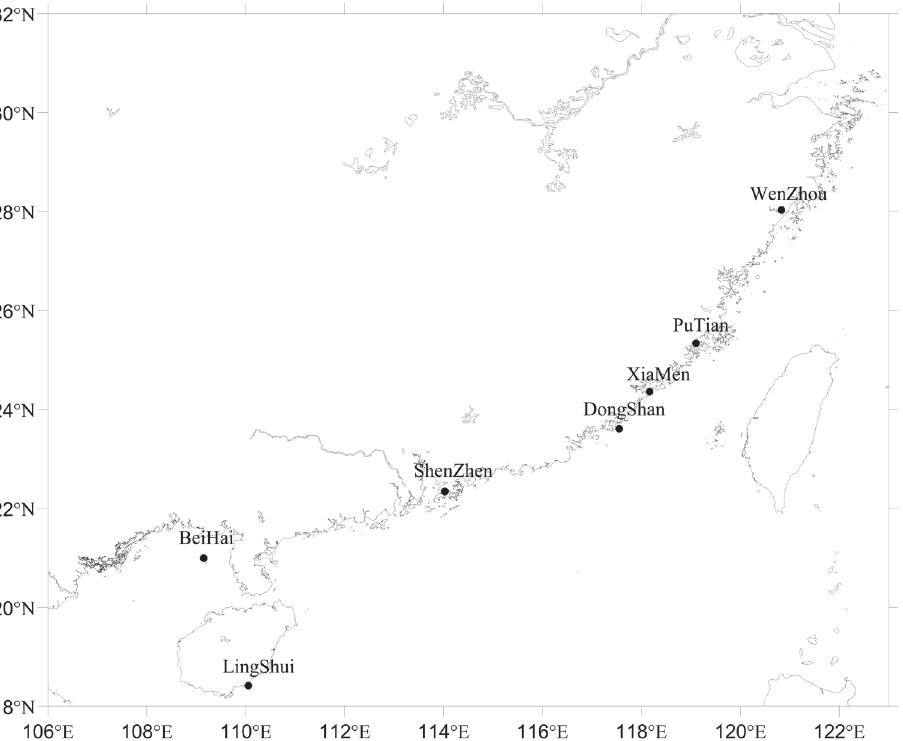
Figure 1. Sample collection locations along the Pacific coast of